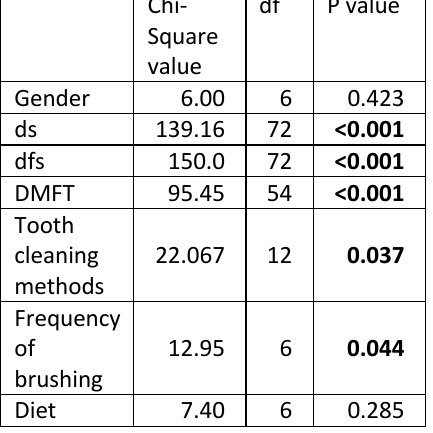
Table II: Association (Pearsons chi square) between the Colony forming units of candida, brushing habits, and dental caries